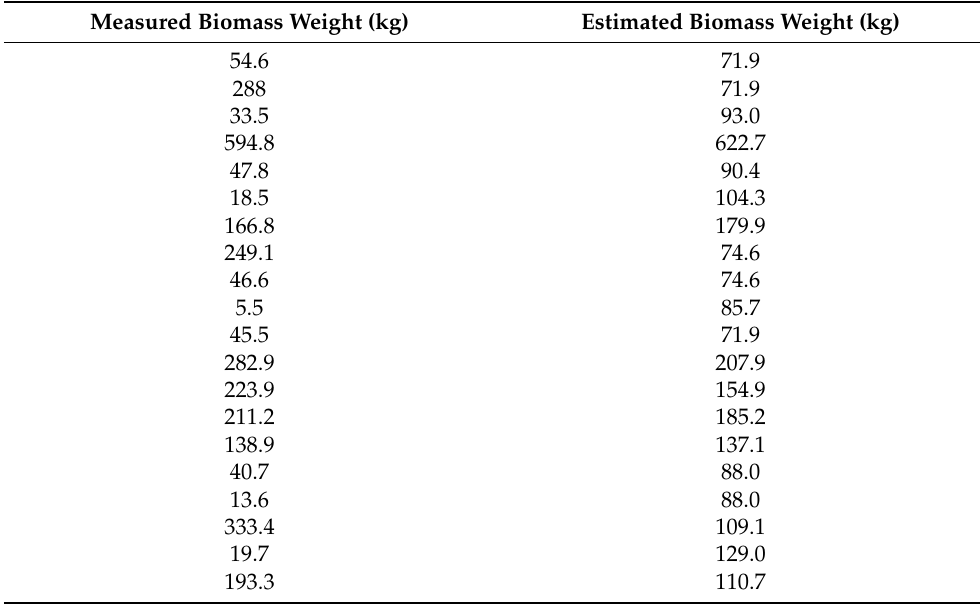
Table 4. Measured and estimated biomass